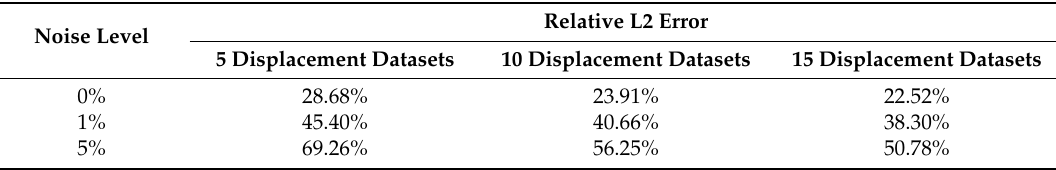
Figure 7. Shear modulus reconstructions with 5% noise. ( a ) target shear modulus distribution for comparison; ( b – d ) reconstructed shear modulus distribution using 5, 10, and 15 boundary displacement data sets, respectively (unit in the scale bar: kPa). Note: “SM” stands for shear modulus. Table 2. Relative L2 error for the cases presented in Figures 5–7.